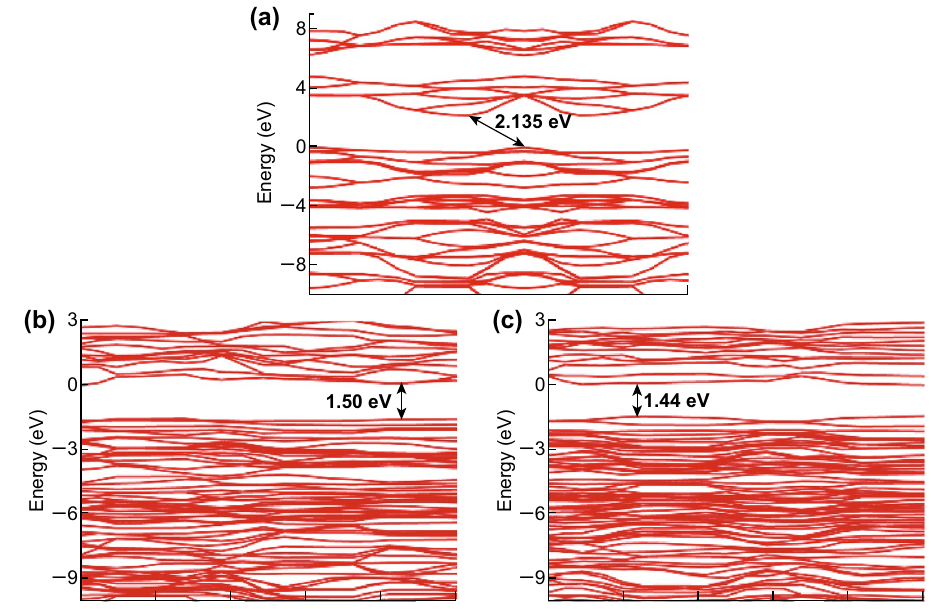
Fig. 9 Band structure of a P-CN, b Mo-CN, and c Co-CN